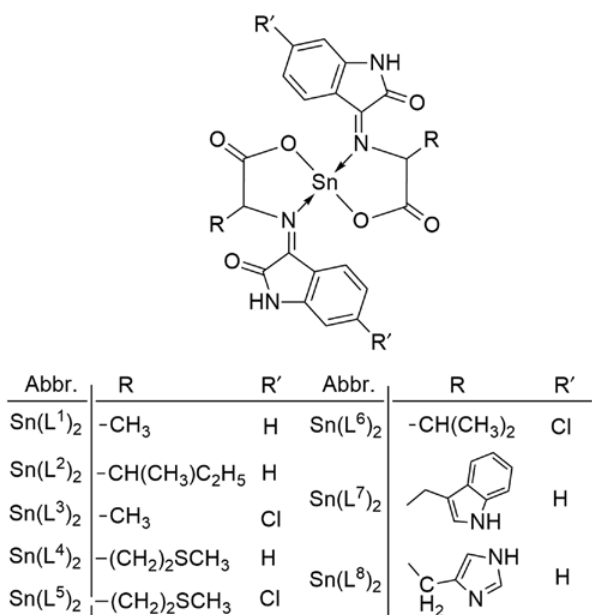
Figure 1: Structure of Sn(II) complexes.